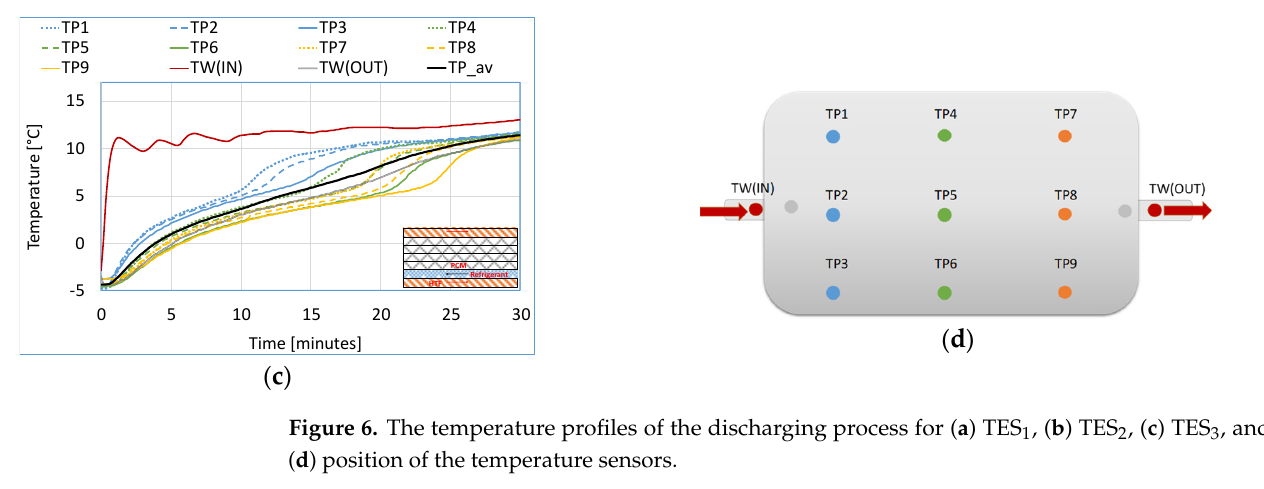
( d ) position of the temperature sensors.